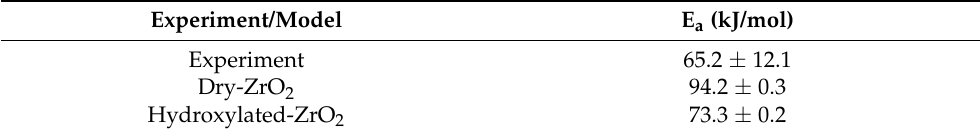
Table 1. Apparent activation energy values from experiment [10] and microkinetic simulations. The reactor parameters, reaction and feed conditions are shown in Table S8 in the Supplementary